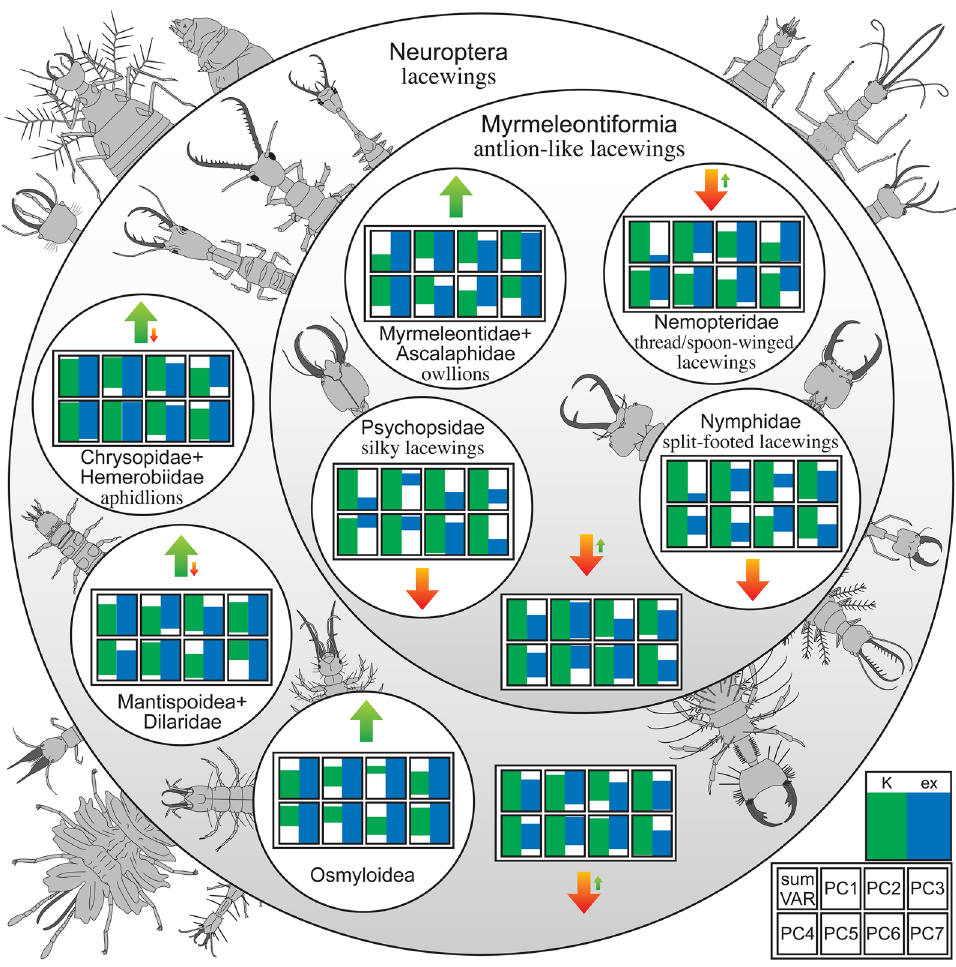
Figure 1. Simplified diversity changes of lacewing larvae in the last 130 million years; relative relationships simplified as Venn diagram. The overall changes of diversity for the different lacewing groups are presented as arrows, with green arrows pointing to diversity increase, orange arrows pointing to diversity decrease; small arrows indicating a diverging diversity change in an ingroup in contrast to the larger group. The boxes indicate the range for the total sum of variance of the bootstrapped and rare-fractioned data sets, and for each principal component separately of the untreated data sets. In total, the diversity of lacewing larvae has decreased (orange arrow at the bottom). Sketches show simplified morphologies of different representatives based on various sources; drawings produced by the authors. ex extant, K Cretaceous, PC principal component, sum VAR sum of variance. More differentiated plot with four time slices in Suppl. Fig.